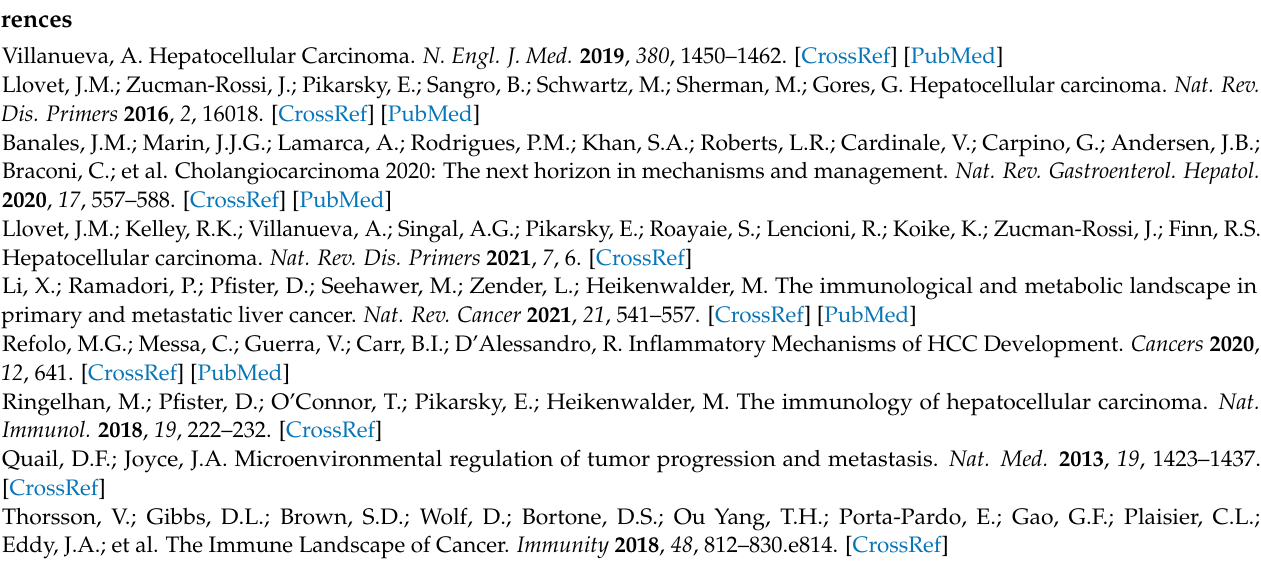
IL-6-like response in HCC cells; Figure S2: STAT3 depletion prolongs IL 6 induced STAT1 phos- phorylation in HepG2; Figure S3: Pairwise correlation of nuclear STAT1 staining with infiltrating immune cells in human HCC tissues; Figure S4: Correlation of STAT1 and STAT3 expression with immune cell infiltration in CCA; Figure S5: Association between nuclear STAT3 expression in the tumor epithelium and immune cell infiltration in HCC tumor samples; Table S1: Clinicopathological characteristics of the HCC cohort ( N = 124) and comparison of patients with STAT1 or STAT3 nuclear low or high staining; Table S2: Clinicopathological characteristics of the CCA cohort ( N = 138) and comparison of patients with STAT1 or STAT3 nuclear low or high staining; Table S3: siRNAs used